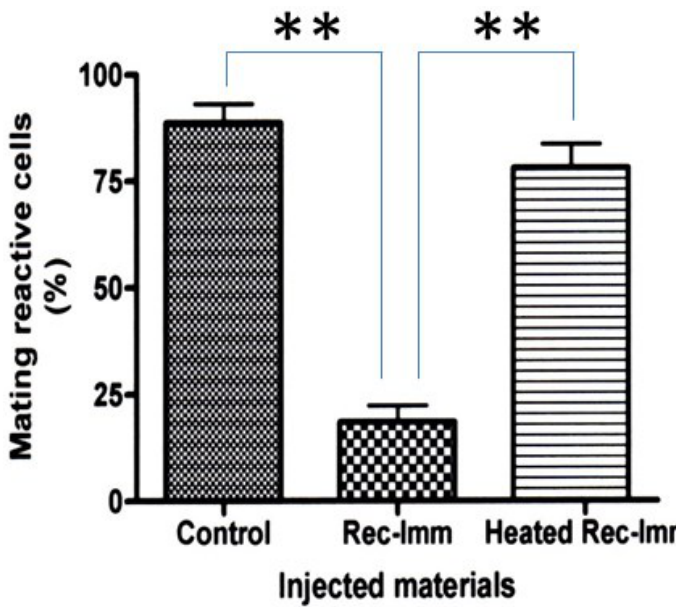
Figure 4. Recombinant immaturin produced by E. coli cells inhibits the expression of mating reactivity in mature Paramecium cells. Microinjection assay was performed as described in Materials and Methods. Rec-Imm indicates recombinant immaturin. Heated Rec-Imm indicates rec-immaturin treated at 100 °C for 10 min. Data represent the average percentage of mating reactive cells ± SD (n = 6). Tukey’s multiple comparison test: ** p < 0.01.